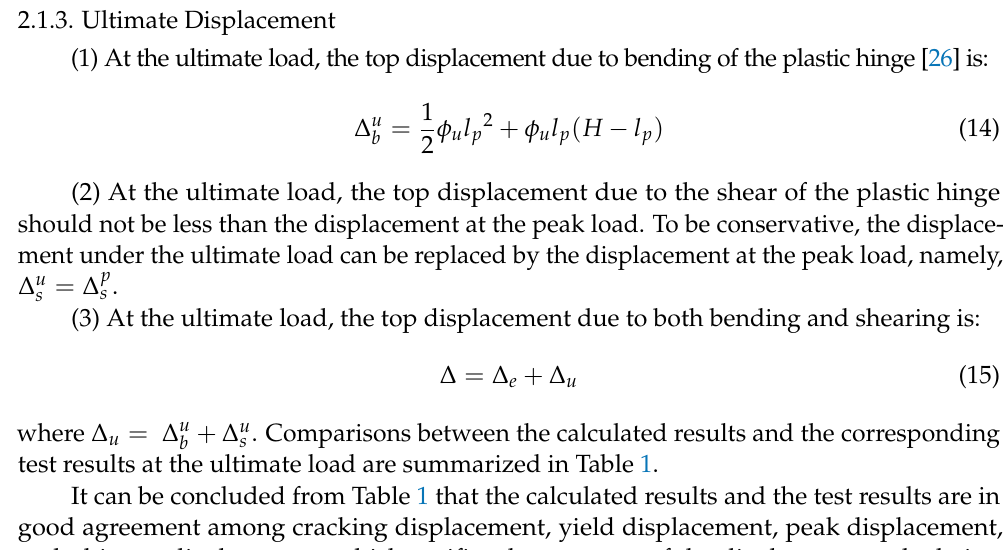
Table 1 summarizes the calculated results and the test results at the peak